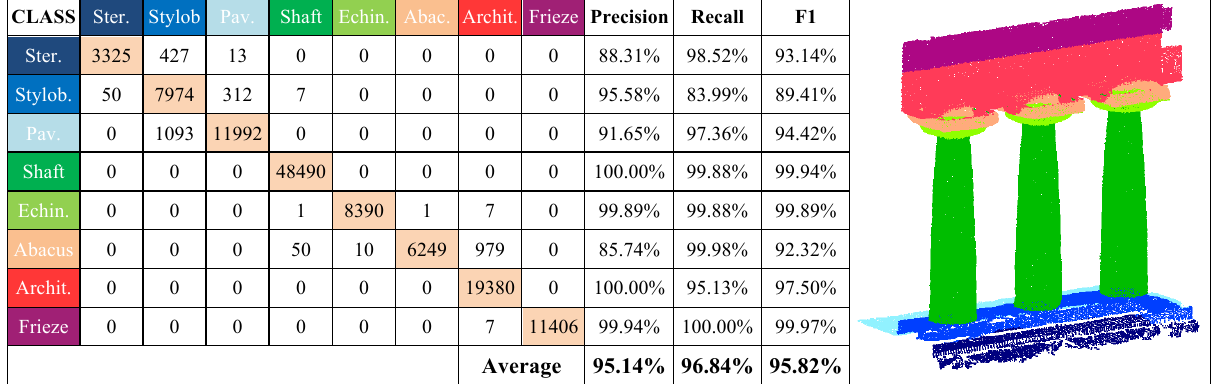
Table 5. Confusion matrix for the Basilica dataset and results, using 8 geometric ad hoc features plus the height information (Z